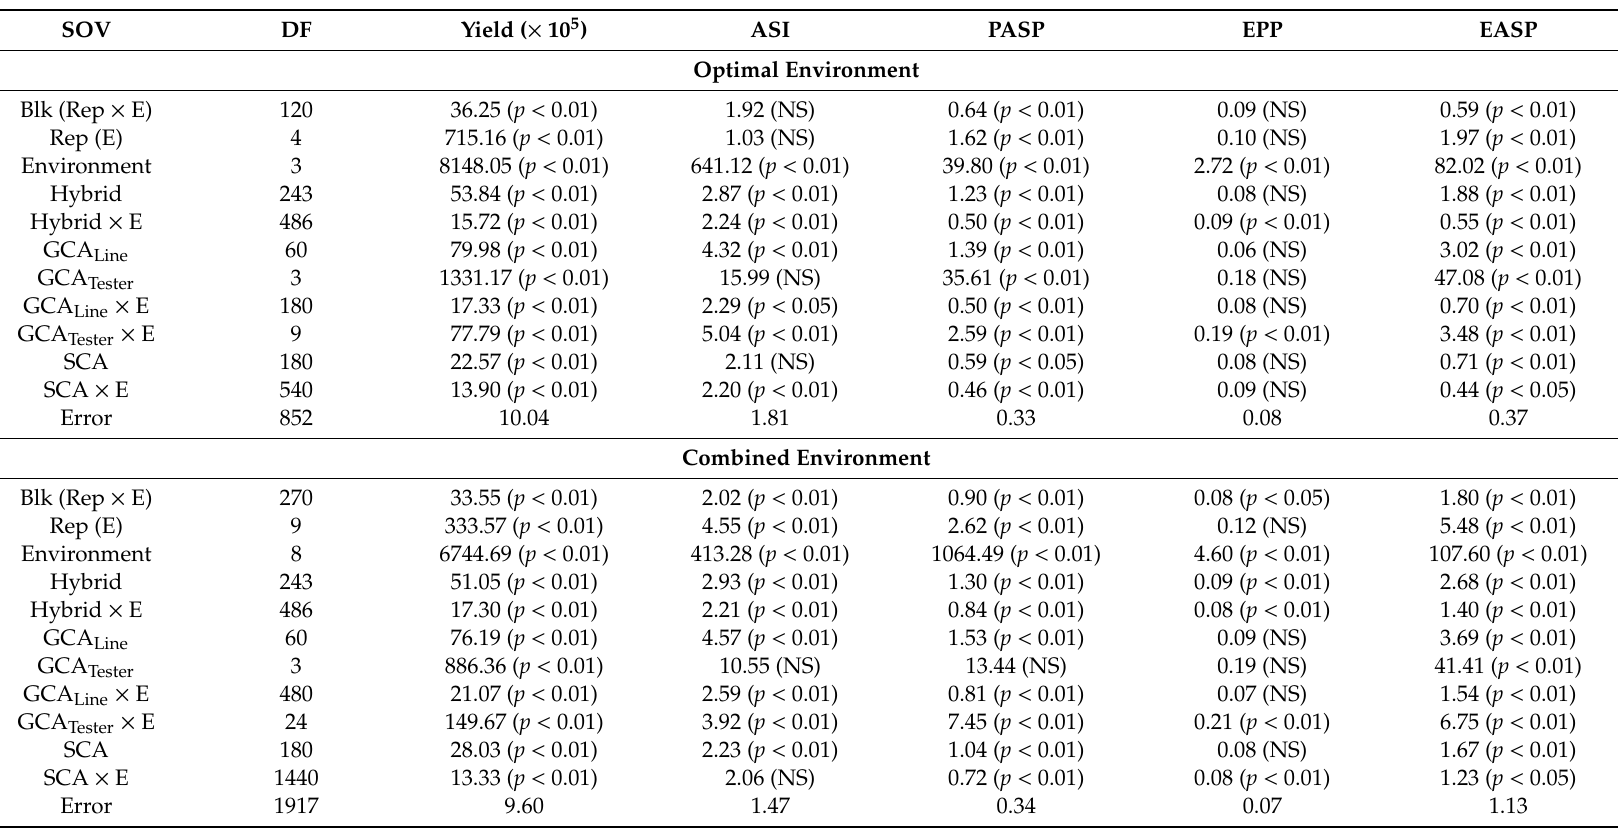
Table 4. Mean squares from line × tester analysis of variance of maize topcrosses evaluated under optimal and combined growing